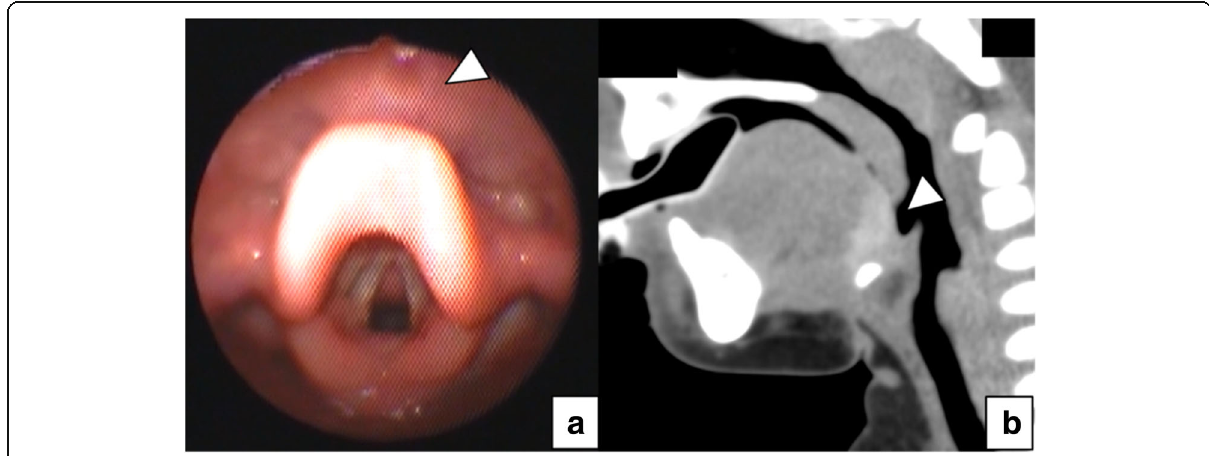
Fig. 3 Postoperative imaging tests. Laryngeal endoscopy performed 6 months postoperatively ( a ) revealed the disappearance of airway compression by the lingual mass, and CT performed 8 months postoperatively ( b ) revealed relocation of the lingual thyroid gland towards the hyoid